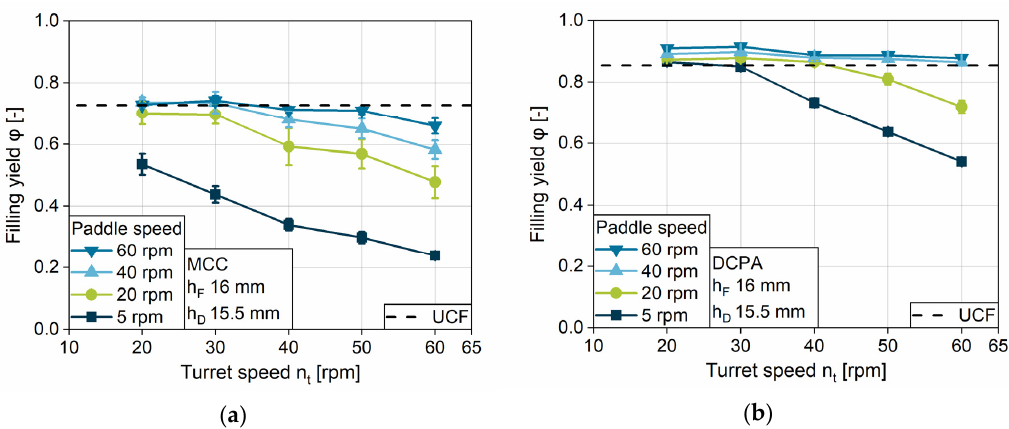
Figure 6. Impact of the turret speed on the filling yield for ( a ) MCC and ( b ) DCPA at different paddle speeds at a fill depth of 16 mm and a dosing depth of 15.5 mm. speeds at a fill depth of 16 mm and a dosing depth of 15.5